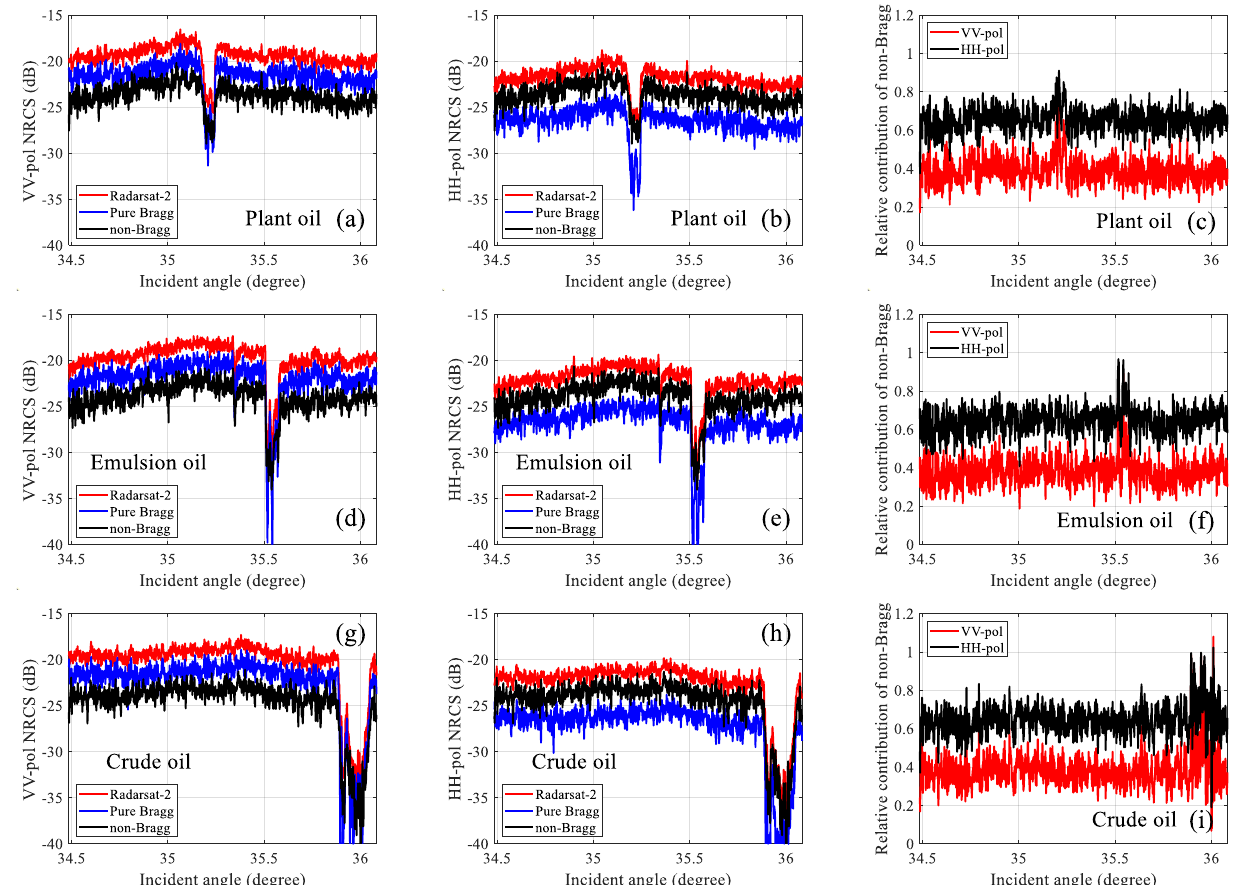
Figure 9. The NRCSs of total scattering, “pure” Bragg scattering and non-Bragg scattering, and the relative contribution of non-Bragg scattering for three kinds of oil films: ( a – c ) for plant oil, ( d – f ) for emulsion oil, ( g – i ) for crude oil.